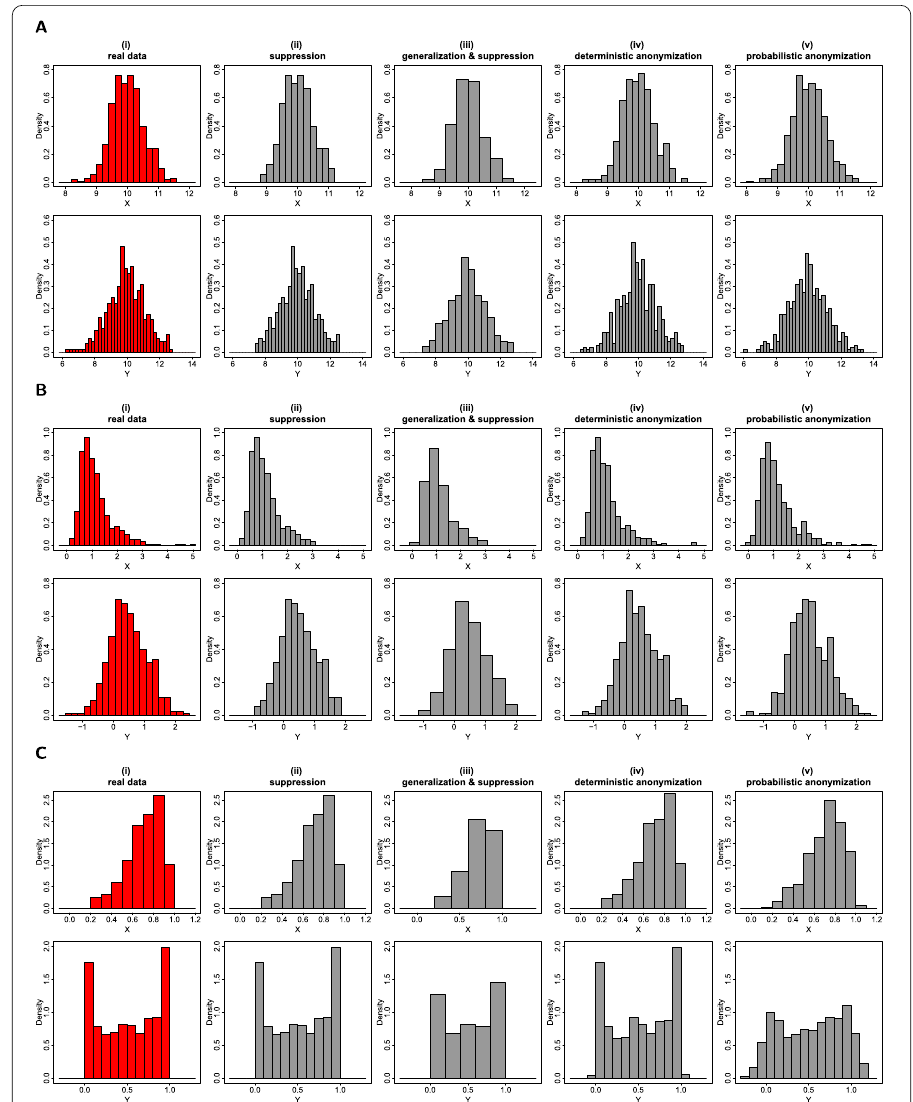
Figure 1 Privacy-preserving histograms. Figures ( A ), ( B ) and ( C ) show the histograms of X (top rows) and Y (bottom rows) from datasets D 1, D 2 and D 3 respectively. From left to right we demonstrate (i) the histograms of the actual variables; (ii) the histograms of the variables after suppressing any bins with less than three counts; (iii) the histograms of the variables after generalizing the variables into bins based on wider intervals and suppressing any bins with less than three counts; (iv) the histograms of the scaled centroids of each 3-nearest neighbours; (v) the histograms of the variables with added noise of variance equal to 6.25% of the true variance. Note that the vertical axis represents the frequency density which is the frequency of each bin divided by its width